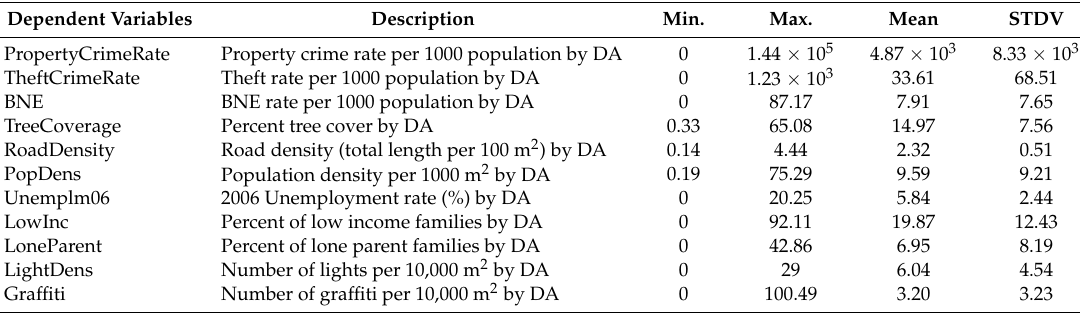
Table 1. Variables